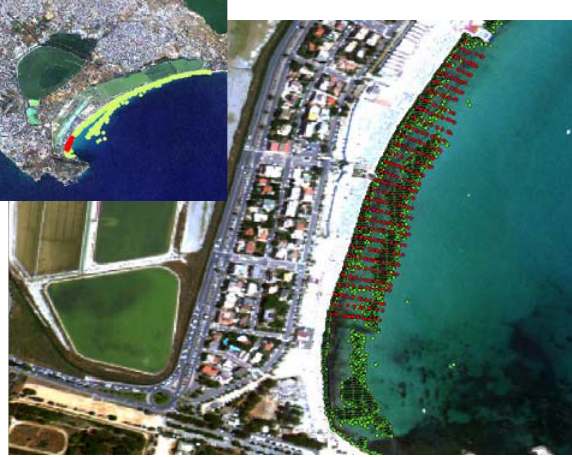
Figure 4. Ground projection of the orbits